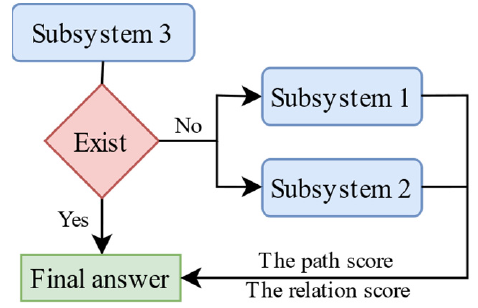
Figure 5. The workflow of path fusion.